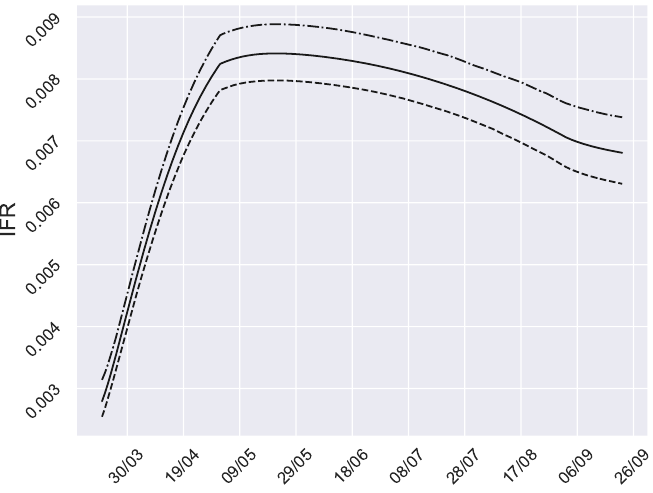
Figure 3. Infection Fatality Ratio (IFR). Evolution of the IFR over time in Granada. Observe that IFR is decreasing in the non-virulence season